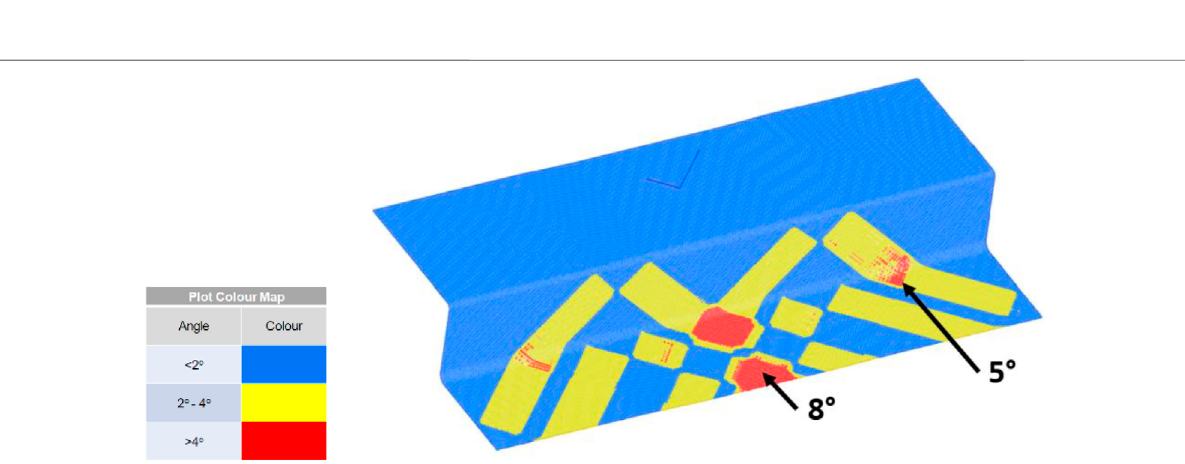
TABLE 2 | Comparison of shear angles predicted by the bias extension test vs kinematic drape model. Shear angle assigned to forming wrinkles using bias extension correction (o)